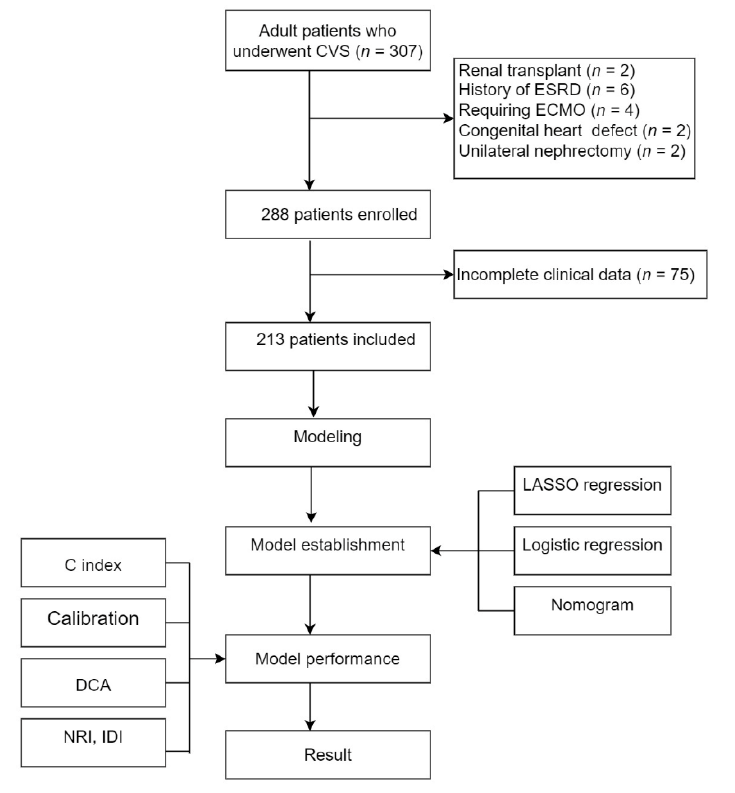
Figure 1. The flow chart of this study.